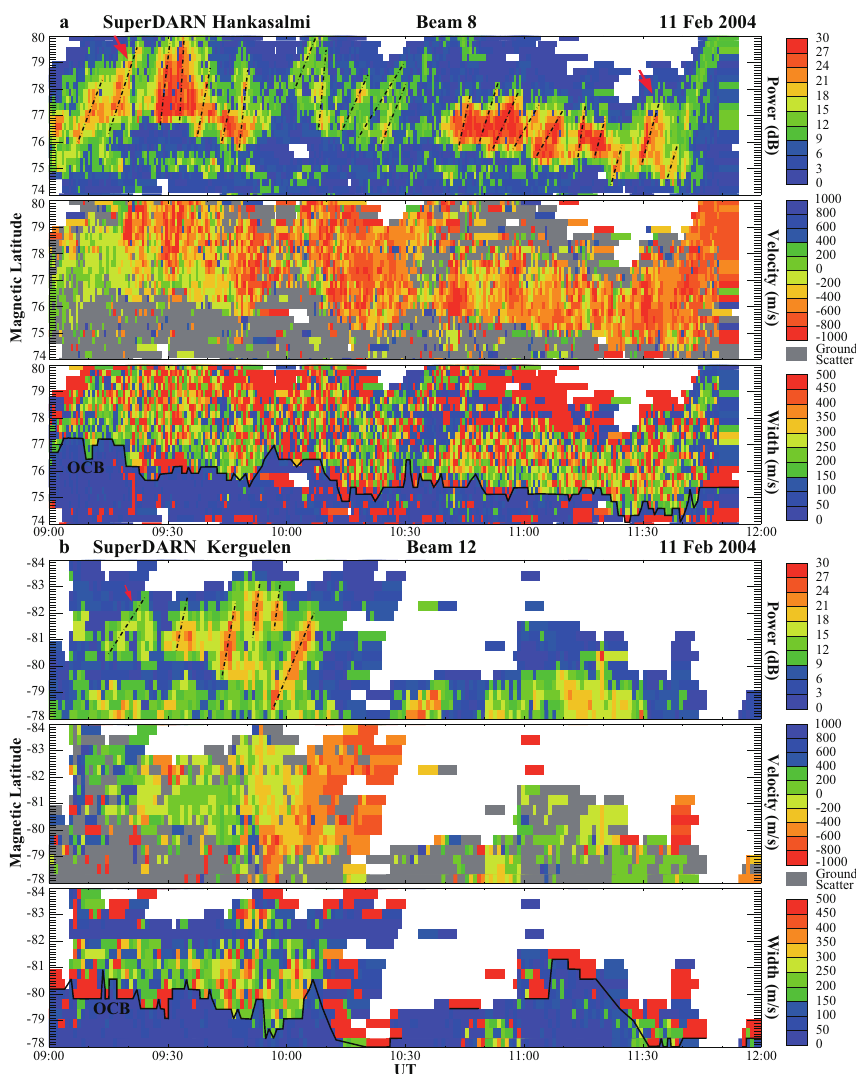
Fig. 8. Backscatter power, l-o-s Doppler velocity, Doppler spectral measured by the (a) CUTLASS Finland and (b) Kergulen SuperDARN radar, respectively, during the period 09:00–12:00UT on 11 February